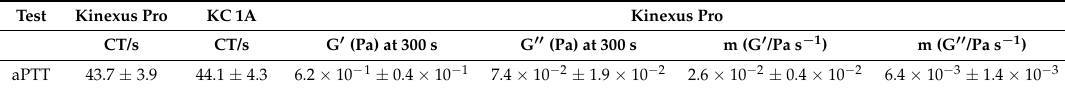
Figure 2. The activated partial thromboplastin time (aPTT) is performed as a further coagulation assay with the oscillatory rheometer. Citrated blood was activated by Pathromtin and CaCl 2 . ( a ) The mean of n = 10 measurements with respective standard deviations are shown. The measurement was performed at a shear stress of 0.04 Pa with 0.1 Hz and a 1°/40 mm stainless steel cone geometry; ( b ) Enlarged part from diagram ( a ). The dashed red line at 0.02 Pa visualises the elastic shear modulus and the dotted blue line at 0.05 Pa the viscous shear modulus of uncoagulated citrated blood with no coagulation activator. After the addition of the activator Pathromtin and CaCl 2 an increase of G ′ and G ″ was observed. The clotting time (CT) is about 43.7 s (black solid line). The values of G ′ and G ″ at 300 s are smaller in comparison to the PT control measurements. Table 2. Citrated blood activated by Pathromtin and CaCl 2 ( n = 10). Summary of the clotting time (CT), elastic (G ′ ) and viscous (G ″ ) shear moduli at 300 seconds and linear slopes (m (G ′ ) and m (G ″ )). Test Kinexus Pro